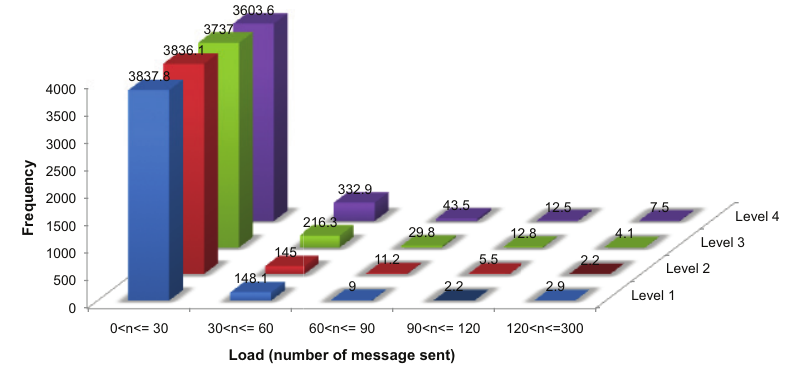
Figure 10. Load balance for communication messages (averaged over 10 networks of 4000 nodes and 10 consecutive